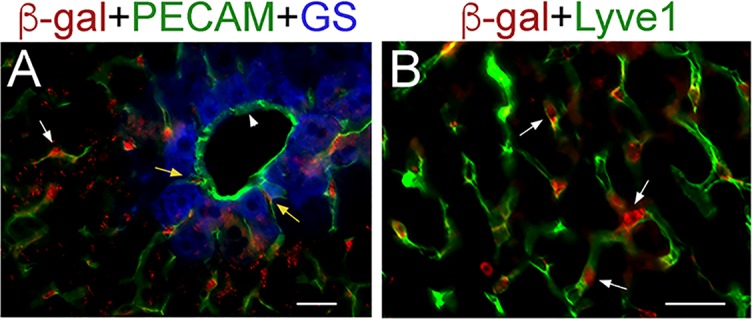
Lineage tracing results demonstrate selective β-gal expression in LSECs in Lyve1-Cre;ROSA-LacZ livers.(A, B) Immunofluorescence results showing expression of the lineage tracer β-gal in PECAM+ endothelial cells connecting to the central vein (A, yellow arrows) and in parenchymal PECAM+/Lyve1+ LSECs (white arrows in (A and B). β-gal is not expressed in PECAM+ central vein endothelial cells (A, arrowhead; the central vein is surrounded by GS+ hepatocytes). Images are representative of 2 individual livers. Scale bars: 25 μm.